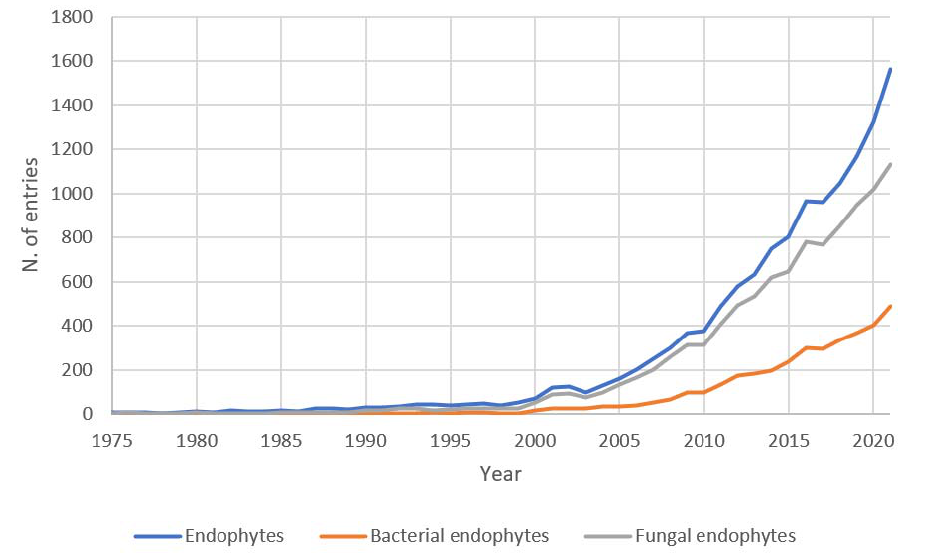
Figure 1. Number of entries by year (starting from 1975) present in PubMed database. Searches with keyword “Endophytes”, “Fungal Endophytes” and “Bacterial Endophytes” are shown.